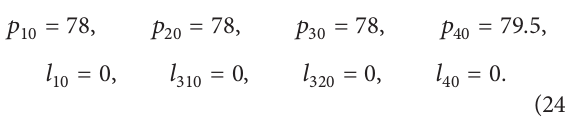
Figure 5: Phase plane trajectories of 𝑝 4